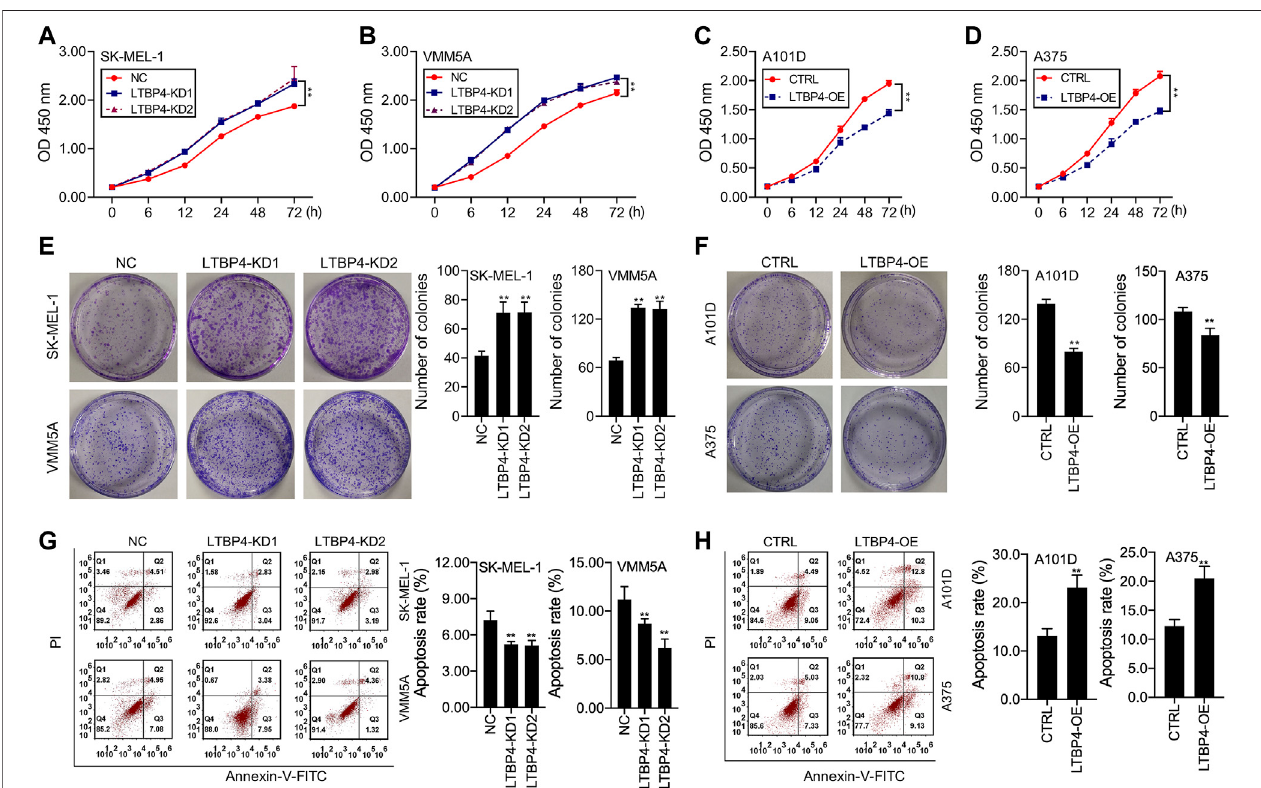
FIGURE 3 | LTBP4 signi fi cantly regulated the proliferation and apoptosis in melanoma cell lines (A and B) The viability of shRNA-LTBP4#1 or #2 transfected SK- MEL-1andVMM5AcellswasdetectedbyCCK-8assay (C and D) TheviabilityofLTBP4expressingplasmidstransfectedA101DandA375cellswasdetectedbyCCK- 8assay. (E) TheproliferationofshRNA-LTBP4#1or#2transfected SK-MEL-1and VMM5Acellswasdetectedbycolonyformationassay. (F) TheproliferationofLTBP4 expressing plasmids transfected A101D and A375 cells was detected by colony formation assay. (G) The apoptosis level of shRNA-LTBP4#1 or #2 transfected SK-MEL-1 and VMM5A cells was detected by fl ow cytometry assay. (H) The apoptosis level of LTBP4 expressing plasmids transfected A101D and A375 cells by fl ow cytometry assay. Data are presented as the mean ± standard deviation. ** p < 0.01 vs NC/CTRL group.